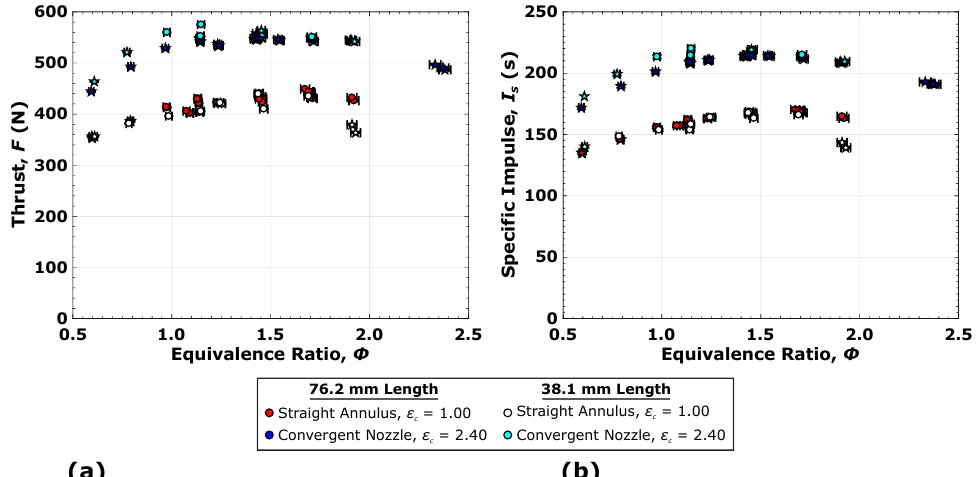
Figure 14. Performance summary for the shortened annular length study showing ( a ) thrust F and ( b ) specific impulse I s for the equivalence ratio flow conditions at ˙ m tot = 0.272 kg/s. Depending on the flow condition and convergent nozzle geometry, the engine operates in either a corotating ( • ) or counter-propagating mode ( (cid:63)